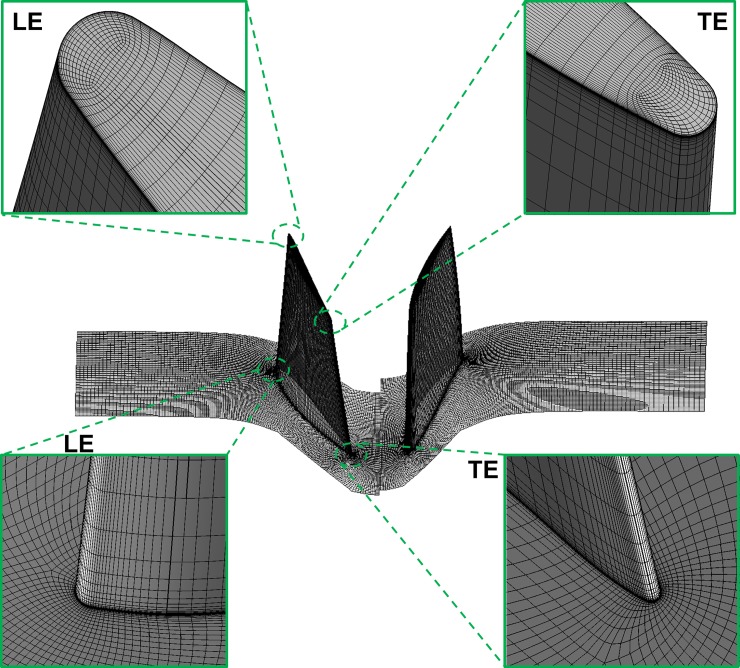
Computational mesh of contra-rotating fan.